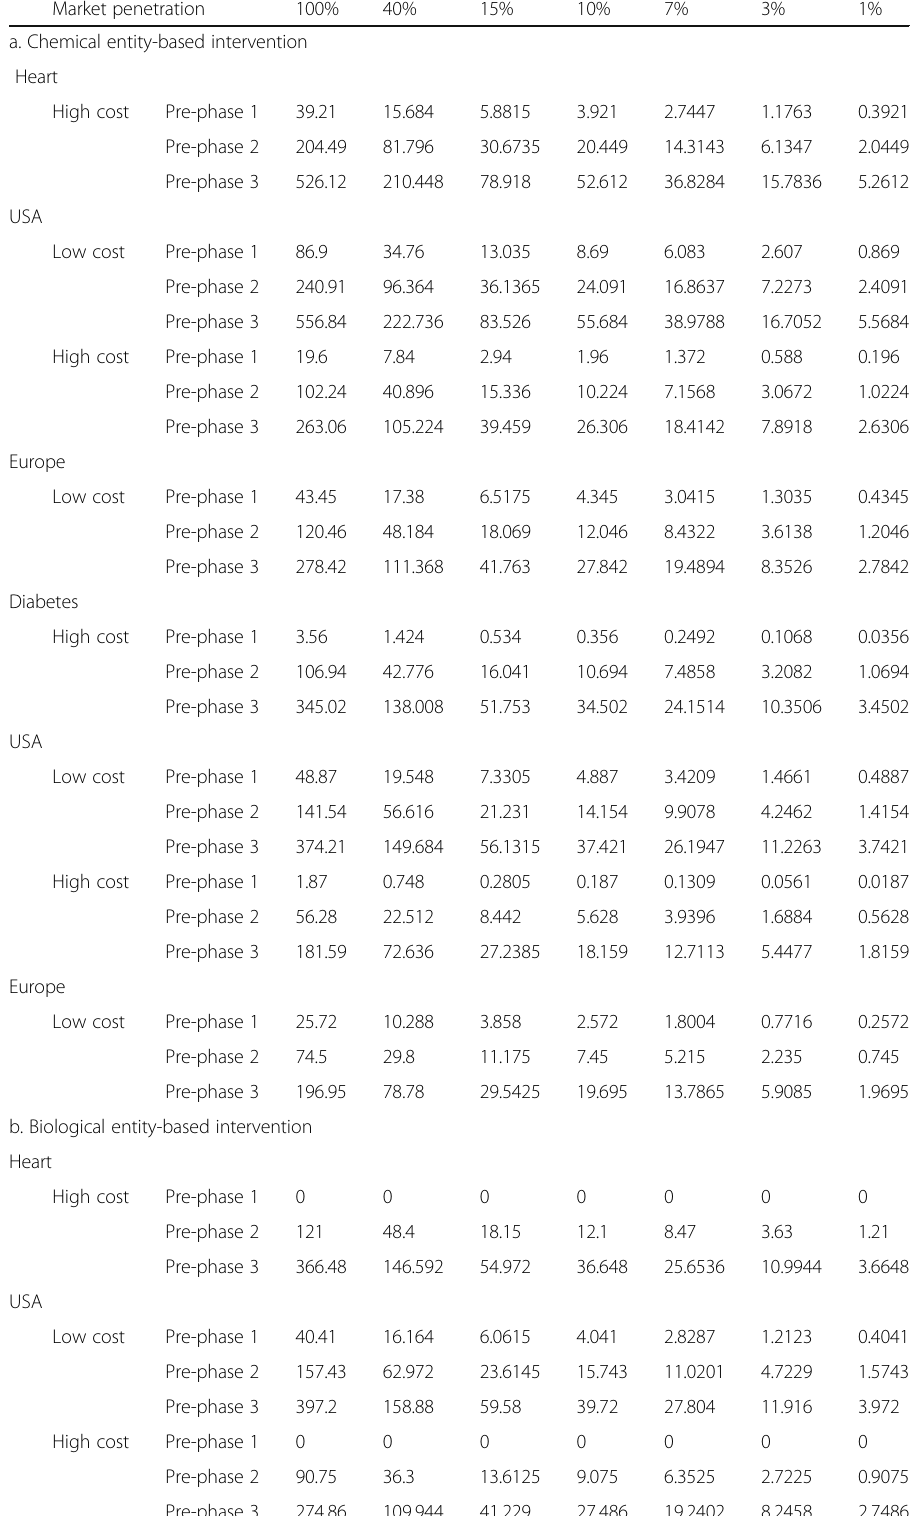
Table 6 SOM rNPVs for each market using real-world data potential market share (numbers in millions of